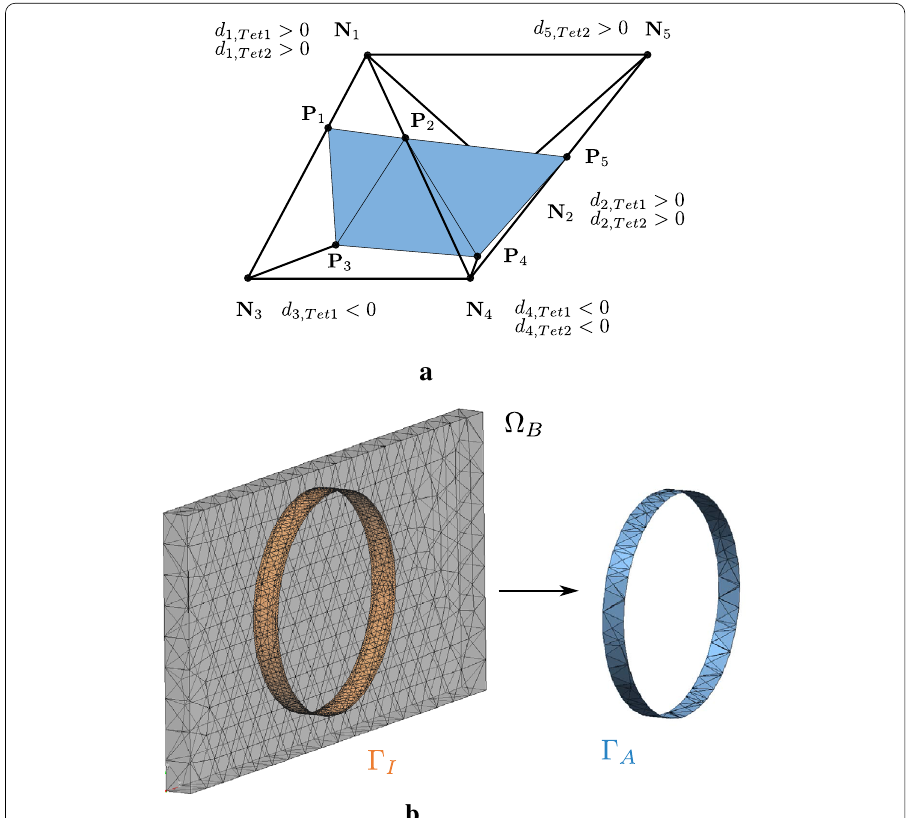
Fig. 9 Visualization of the geometry approximation resulting from an implicit description of the immersed object by a discontinuous distance function. a Concept: visualization by surface reconstruction. b Example: approximation of an immersed